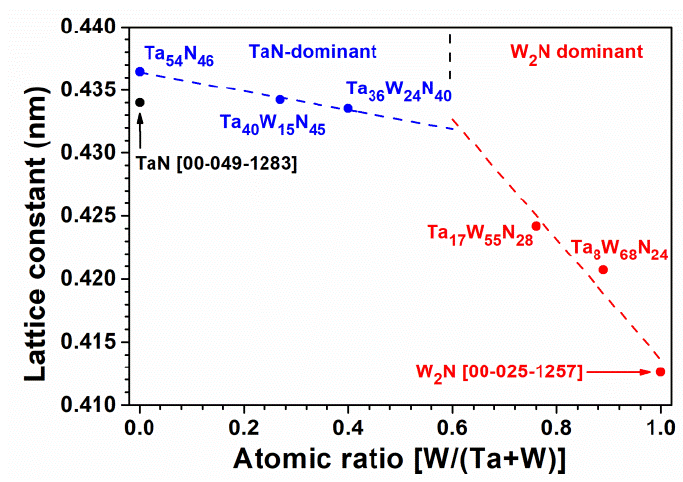
Figure 5. Lattice constants of the TaWN films.